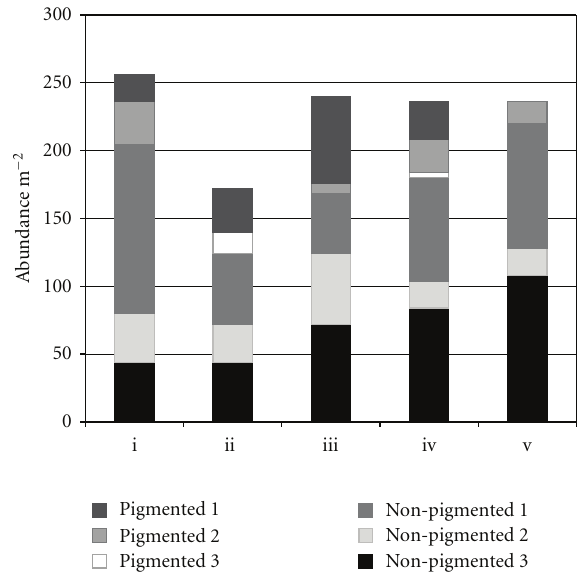
Figure 1: Abundance of earthworms by pigmentation and size class, in biochar plots sampled at Rosemount, MN; treatments are (i) control (no amendment), (ii) composted manure; (iii) fast pyrolysis hardwood biochar, (iv) fast pyrolysis hardwood biochar + manure, (v) fast pyrolysis macadamia nut biochar. See text for description of size